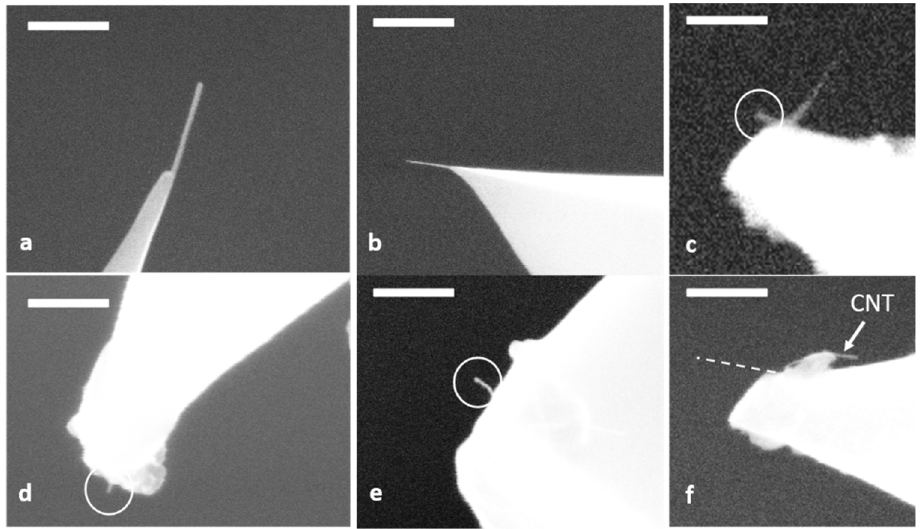
Figure 3. SEM images of CNTs attached to AFM tips. The scale bars in each image are ( a ) 200 nm, ( b ) 500 nm, ( c ) 200 nm, ( d ) 200 nm, ( e ) 200 nm and ( f ) 200 nm. It can be seen in ( f ) that the electron beam moved the CNT from a relatively straight position, given by the dotted line, to a bent position.